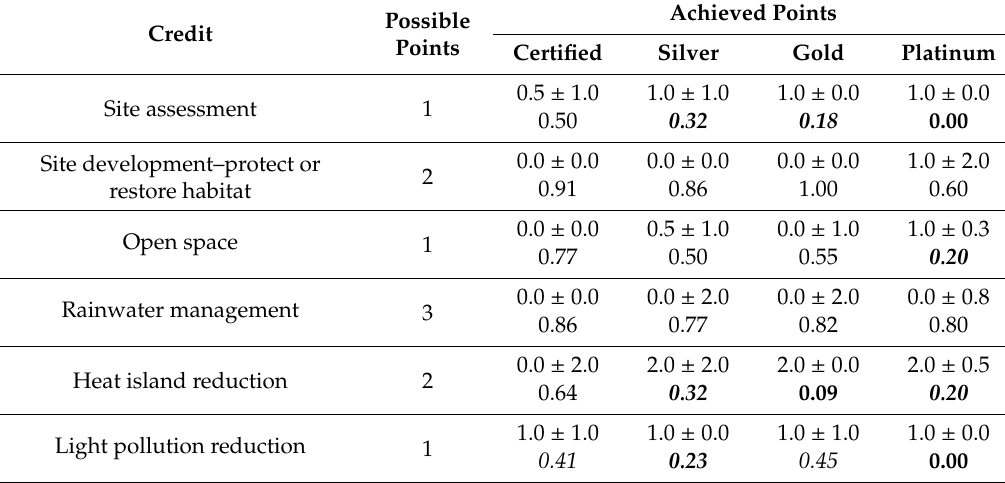
Table3. CreditpointsachievedforSustainableSites(SS)categoryofLEED-NCv4projects: median ± IQR (25th–75th) and Cli ff ’s δ e ff ect size between possible and achieved points in a credit.